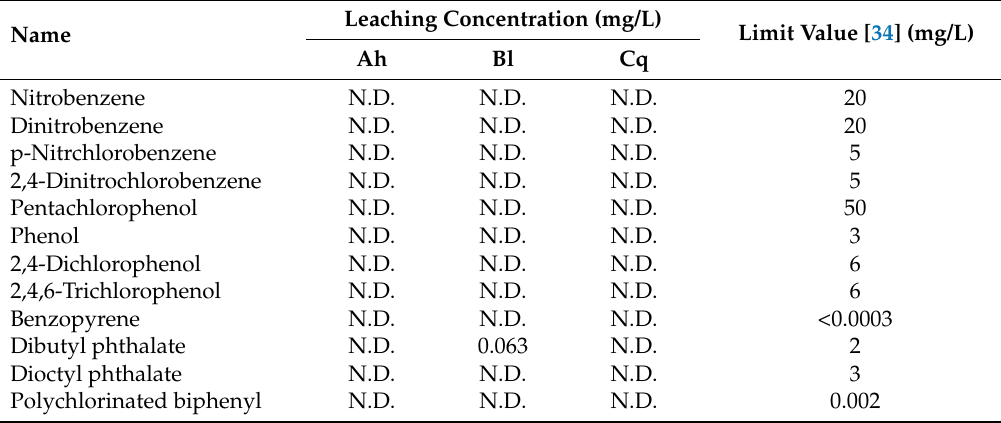
Table 2. Determination of non-volatile organic matter in excess sludge leachate.